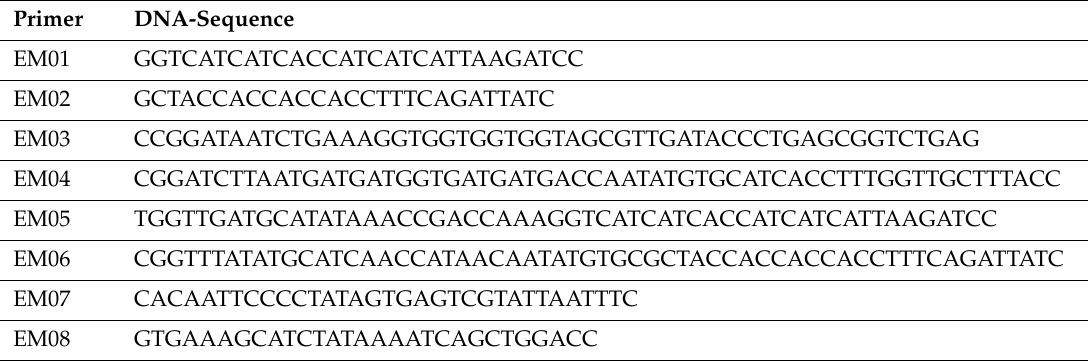
Table 1. Primers used in this study.